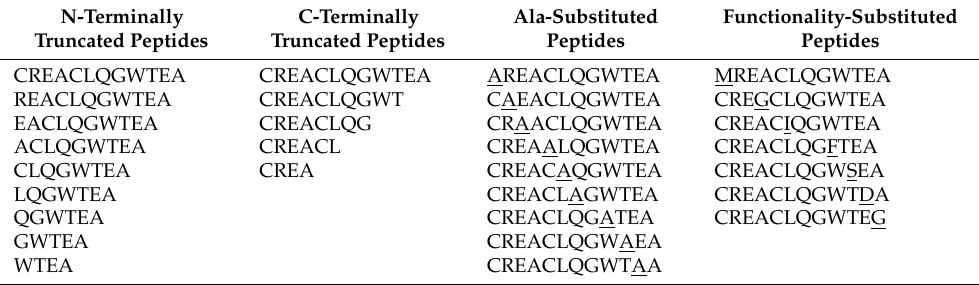
Table 5. Synthetic peptides used for characterization of peptide antibodies. Amino acids underlined represent substituted amino